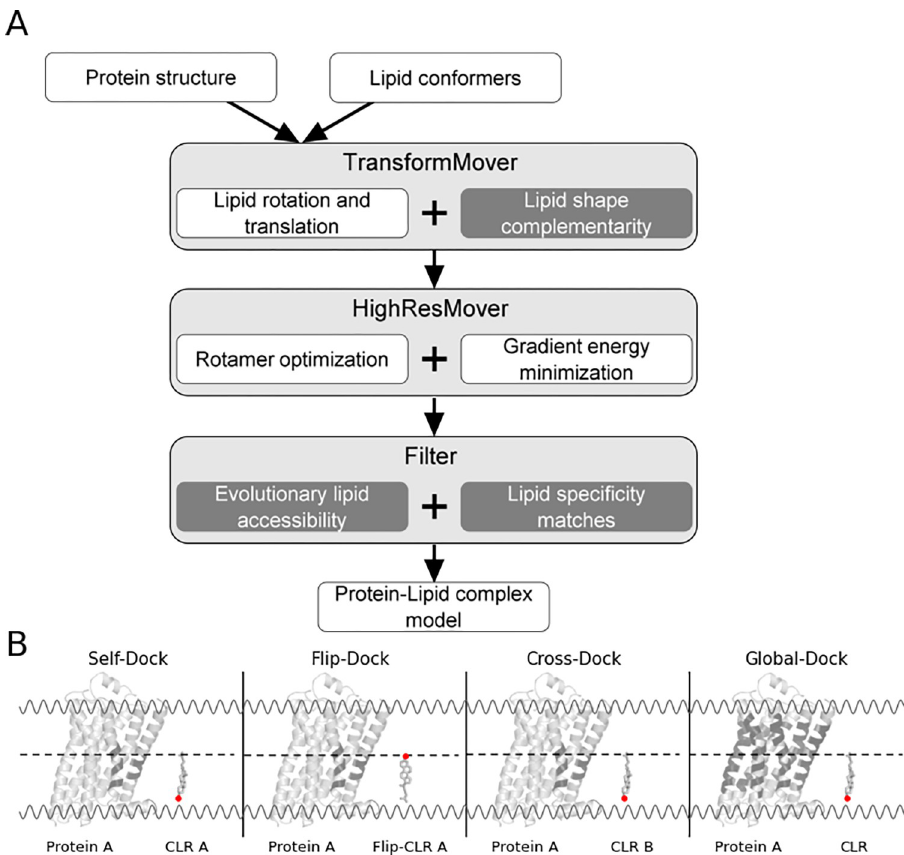
Fig 1. Schematic of the RC protocol. (A) The protocol is divided into docking and filter sections. During the docking (or prediction phase) we use centroid (TransformMover) and full-atom (HighResMover) representations of the protein structure and lipid conformers. Protein and lipid conformer moves are repeated based on the accept/reject Metropolis Monte Carlo ratio. In the filtering section, the evolutionary lipid accessibility and lipid specificity matches are used to determine the specificity score. The specificity score determines the probability of a protein-cholesterol binding site being specific. The output is an individual protein-lipid complex and a csv file. Highlighted in gray are the additional steps added to the current RosettaLigand protocol that compose the RC protocol. (B) Cartoon representation of each benchmark setup. Protein A and CLR A (self-dock); Protein A and Flip-CLR A (flip-dock); Protein A and CLR B (cross-dock); Protein A and CLR (global-dock). A dashed line depicts the center of the membrane. Protein A is shown in cartoon representation, while CLR is shown in stick representation. An example of the protein area cholesterol is docked into for each benchmark is colored